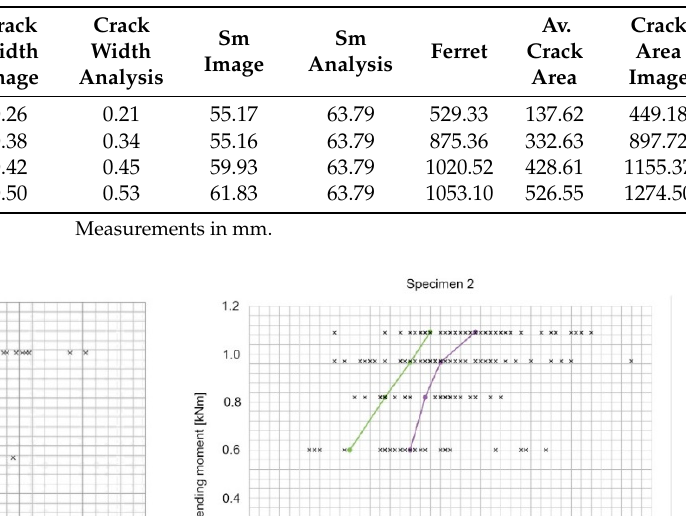
Table 5. Measured and calculated results for Specimen 5.